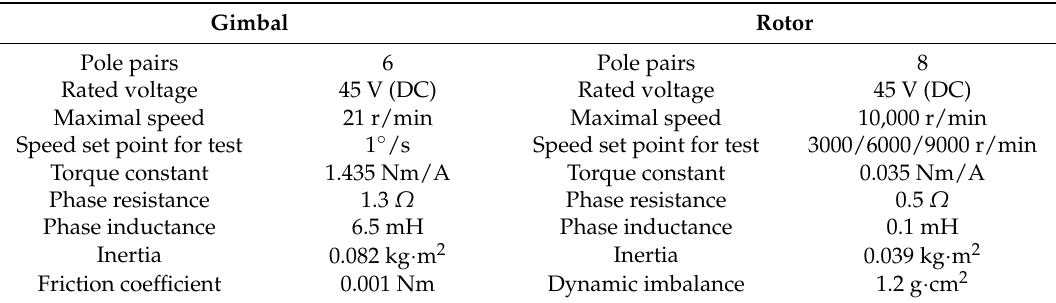
Table 1. CMG parameters.